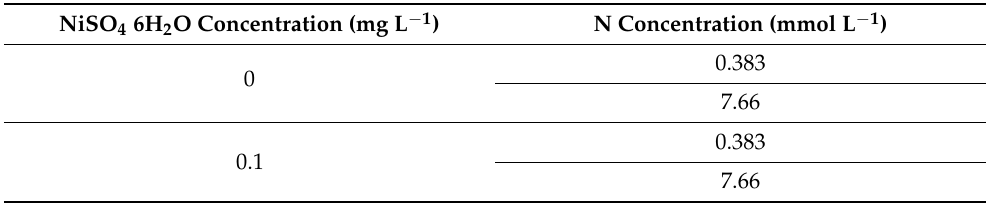
Table 3. Design of